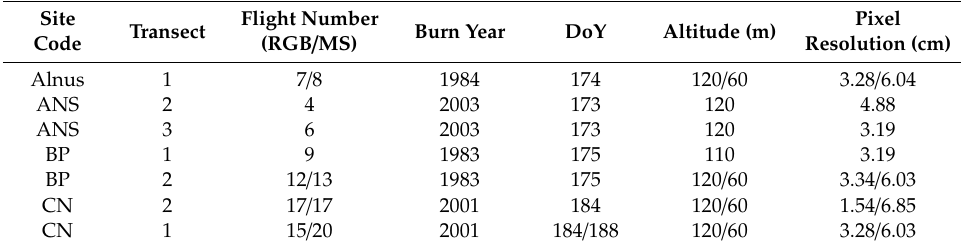
Table 2. Collection details for visible spectrum (RGB) and multispectral (MS) data. All data were collected during the summer 2019. We report the field site code, field transect number, flight numbers for RGB / MS, year of burn, day of year (DoY) flight occurred, altitude of flight, and pixel resolution for processed